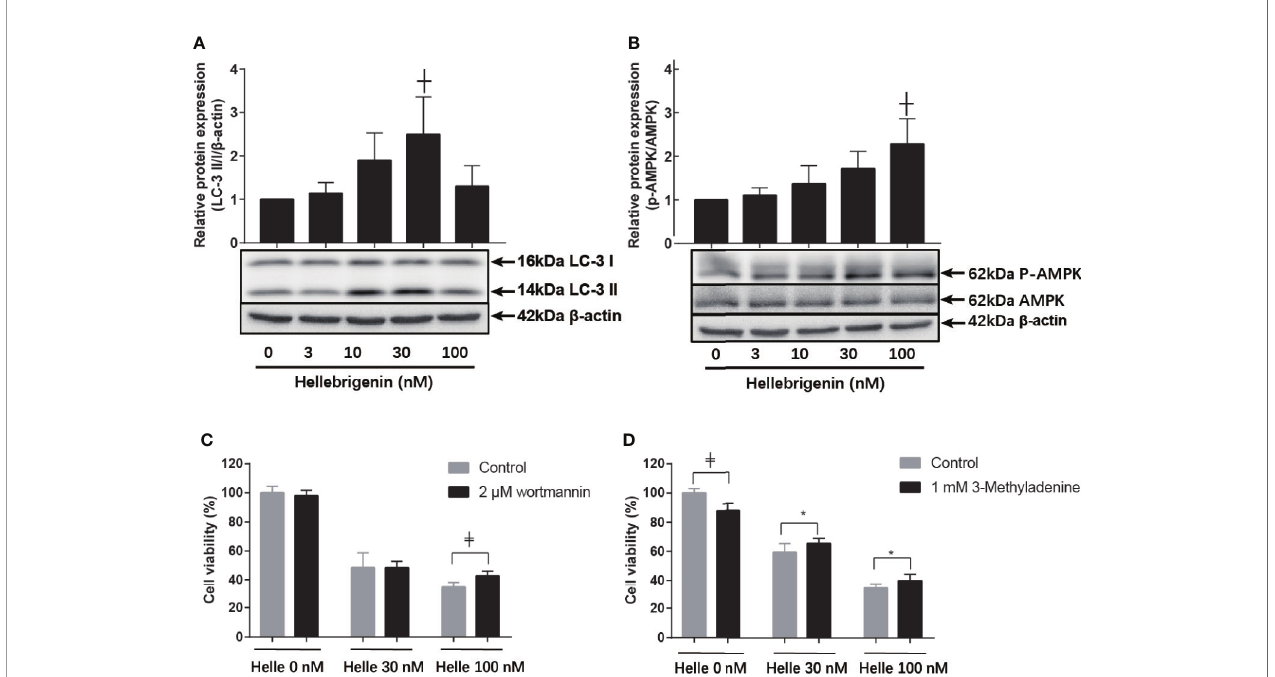
FIGURE 7 | Involvement of autophagic cell death in the cytotoxicity of MCF-7 cells treated with Helle. After treatment with various concentrations of Helle (3, 10, 30 and 100 nM) for 48 h, the expression levels of autophagy induction − related proteins were analyzed by western blotting (A, B) . Cell viability was determined by WST-